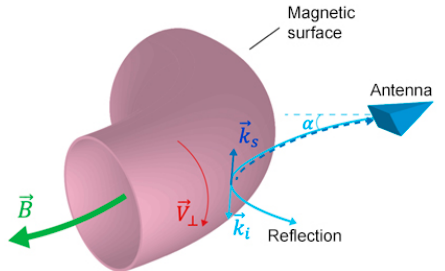
Figure 1. Schematic of a microwave beam incident on the reflection layer. Analysis of the reflected probing beam signals leads to the observation that the Doppler shift in the backscattered frequency spectra is directly proportional to the perpendicular rotation velocity of the density turbulence moving with the